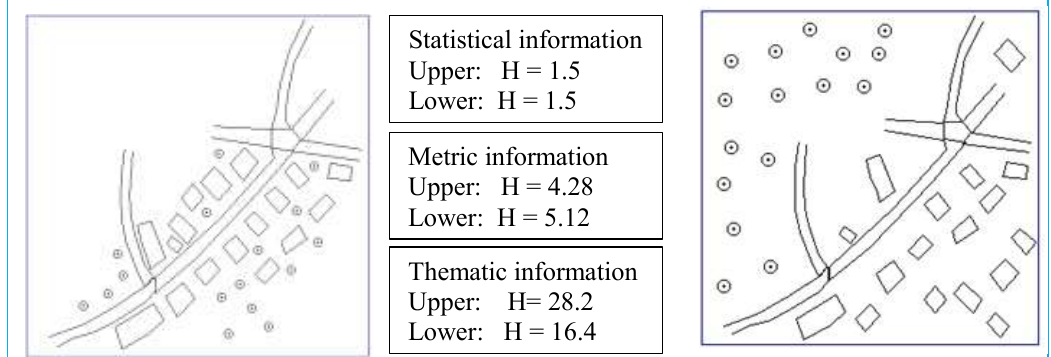
Two maps with same amount of symbols for each type, but very different spatial